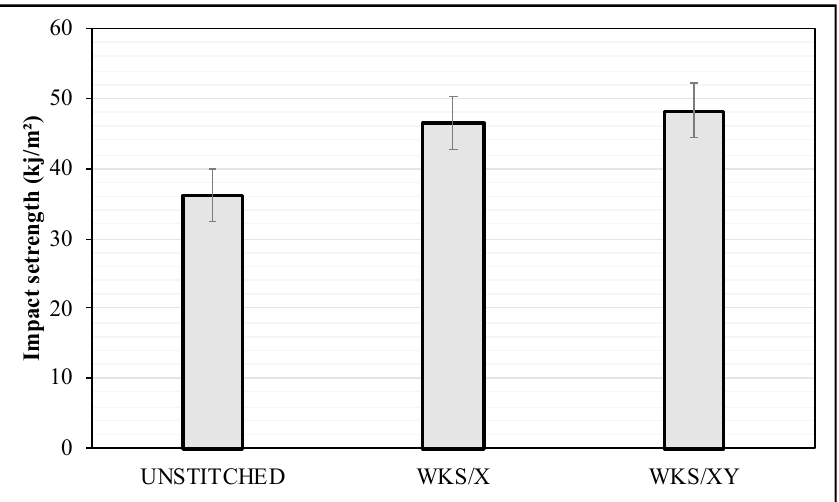
Figure 15. E ff ect of stitching density and pattern on the impact strength of the woven kenaf Figure 15. Effect of stitching density and pattern on the impact strength of the woven kenaf composite.